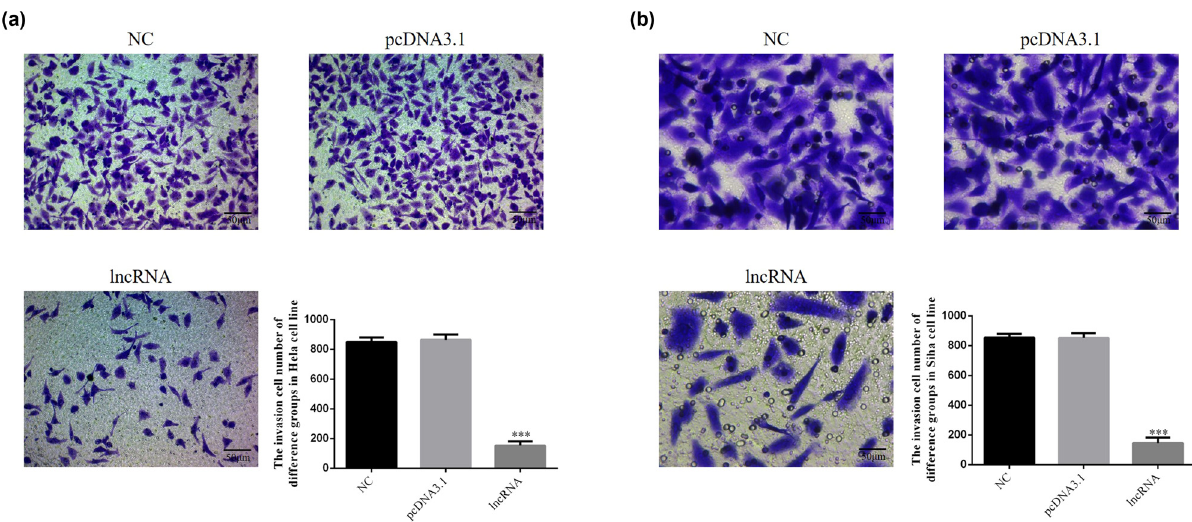
Figure 4: UBE2R2 - AS1 a ff ected invasion cell number of di ff erence groups in HeLa and SiHa cell lines ( 200 ×) . NC: normal control group; pcDNA 3.1: the cells were transfected with pcDNA3.1; lncRNA: the cells were transfected with UBE2R2 - AS1 by pcDNA3.1. ( a ) UBE2R2 - AS1 a ff ected invasion cell number of di ff erence groups in HeLa cell. *** P < 0.001, compared with NC group. ( b ) UBE2R2 - AS1 a ff ected invasion cell number of di ff erence groups in SiHa cell. *** P < 0.001, compared with NC